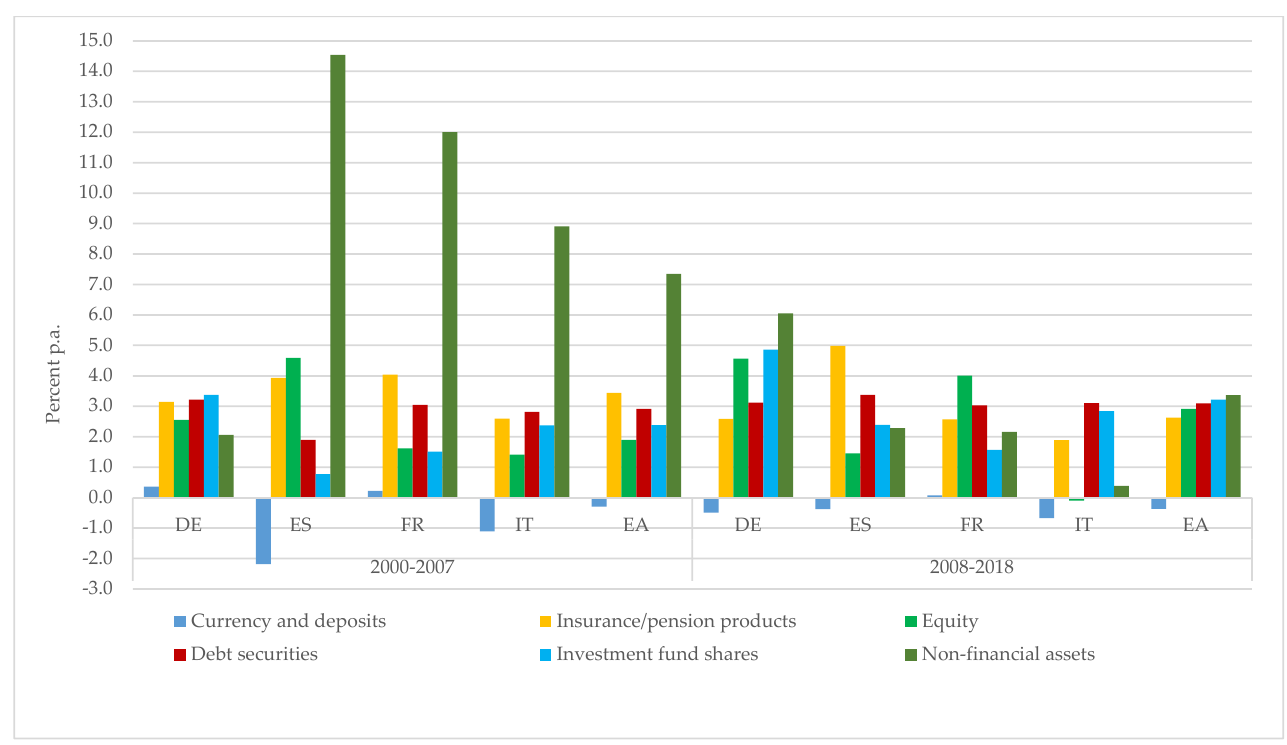
Figure 4. Average real returns on individual assets. Note: DE: Germany; ES: Spain; FR: France; IT: Italy; EA: euro area. Source: authors’ calculations based on ECB, Eurostat, OECD, Thomson Reuters. Table 2. Descriptive statistics—real yields on individual assets.